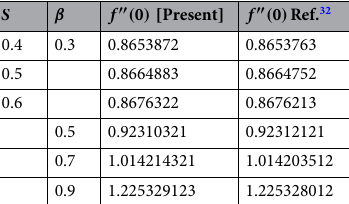
Table 3. Comparison of the present results with Ref 32 considering only common terms n = 0.2, De =